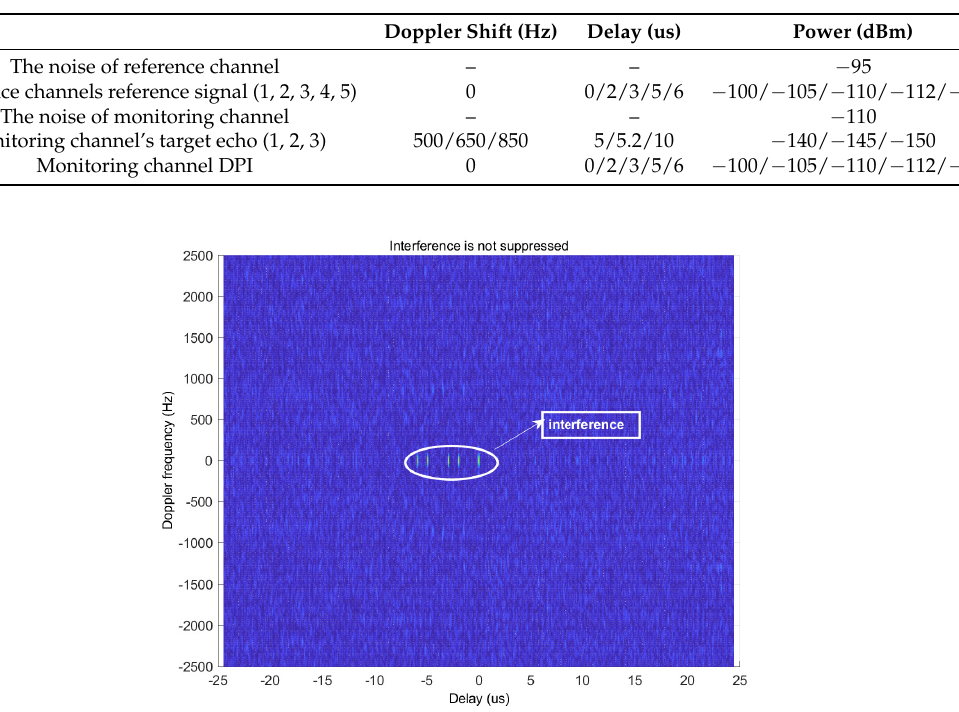
Table 3. Parameter setting.